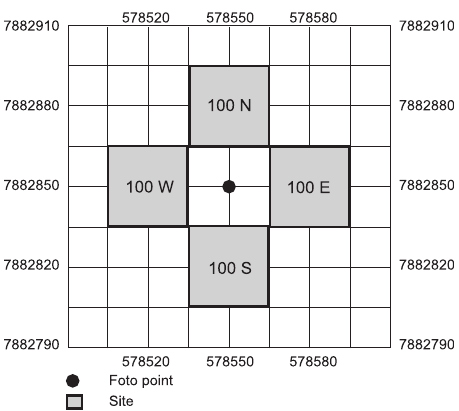
Fig. 3. Geo-coding of sites as derived from the orig- inal coordinates of the photo